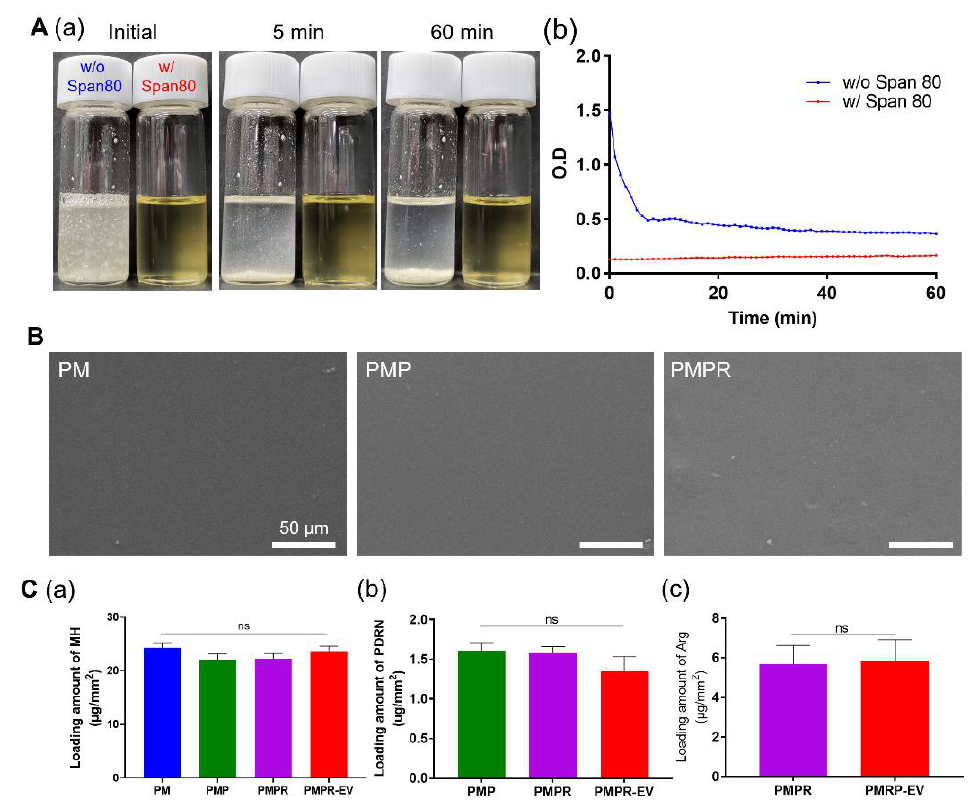
Figure 1. Characterization of the PLLA composites. ( A ) Dispersion stability of the coating solution; dispersion images ( a ) and turbidity assay ( b ) at 550 nm for 1 h. ( B ) The representative SEM images of the PM, PMP, and PMPR. ( C ) Quantification of the loading amount of MH ( a ), PDRN ( b ), and Arg ( c ) in each composite.